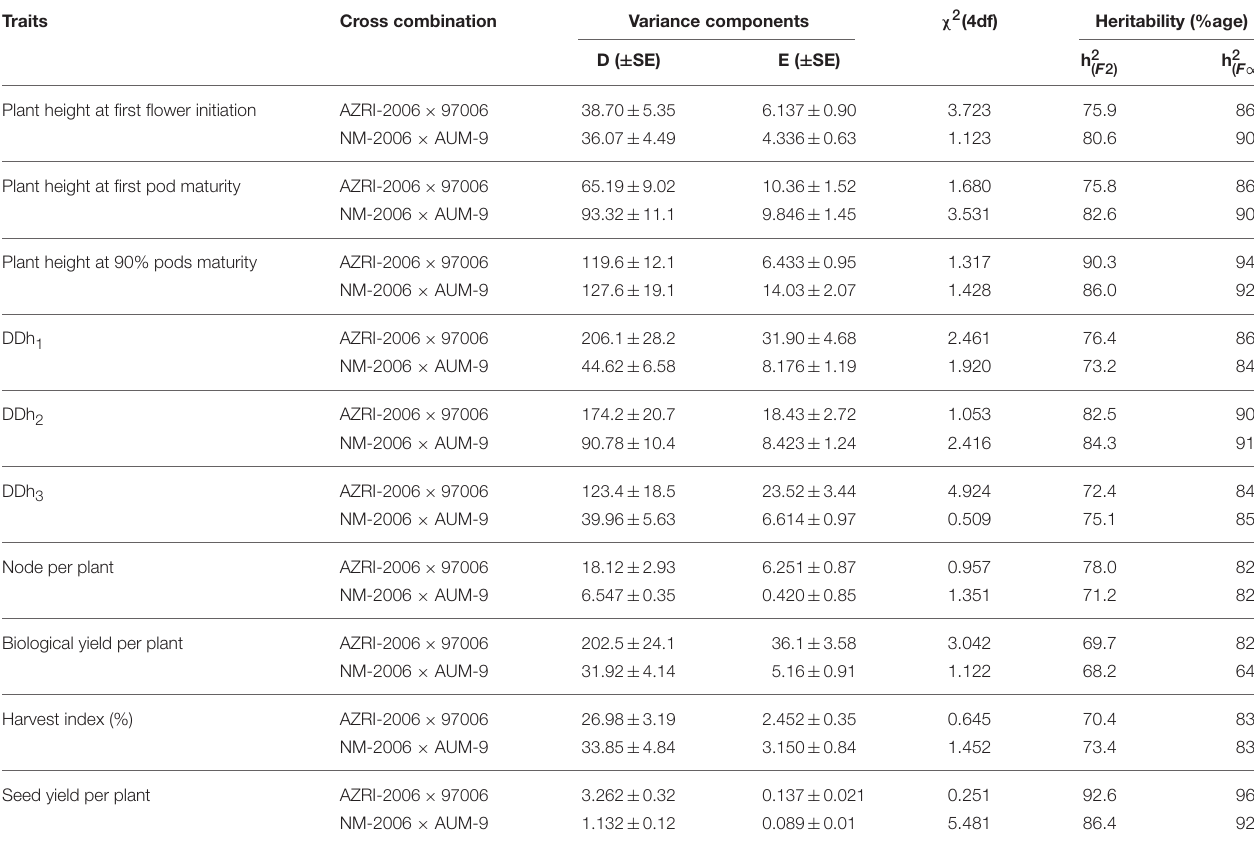
TABLE 5 | Best fit model following weighted analysis of components of variation and narrow sense heritability estimates in two crosses of mungbean.